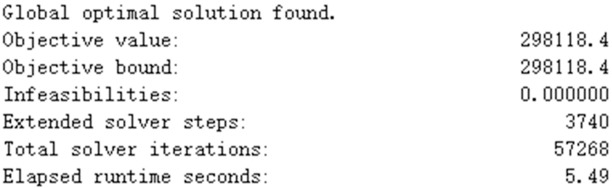
Results of Lingo.